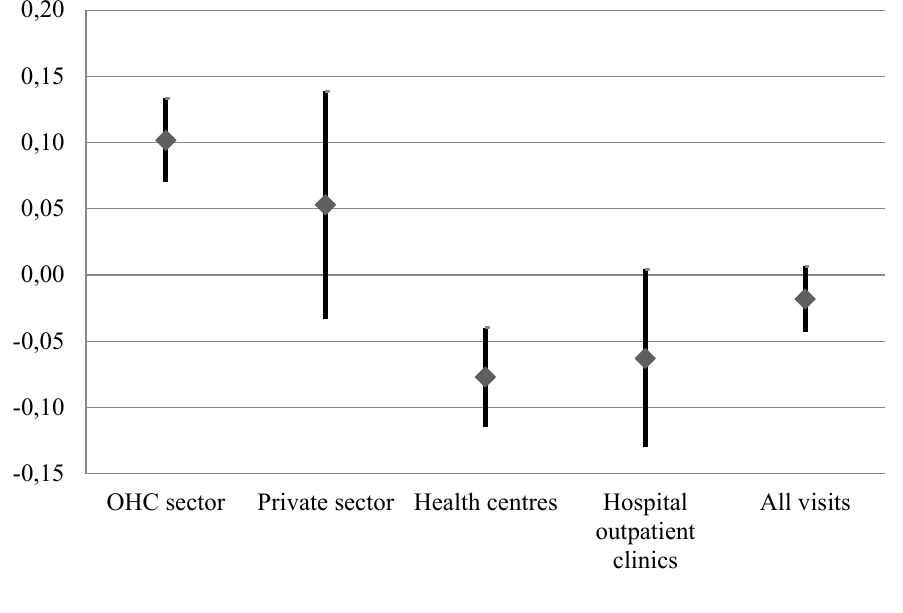
Figure 3: Need adjusted inequity indicies for visits to a